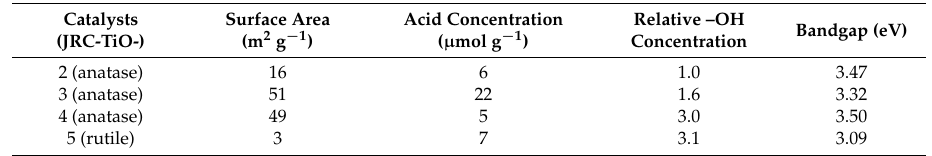
Table 3. Physicochemical properties of the standard reference TiO 2 photocatalysts (JRC-TiO-2, -3, -4, and -5) supplied by the catalysis Society of Japan